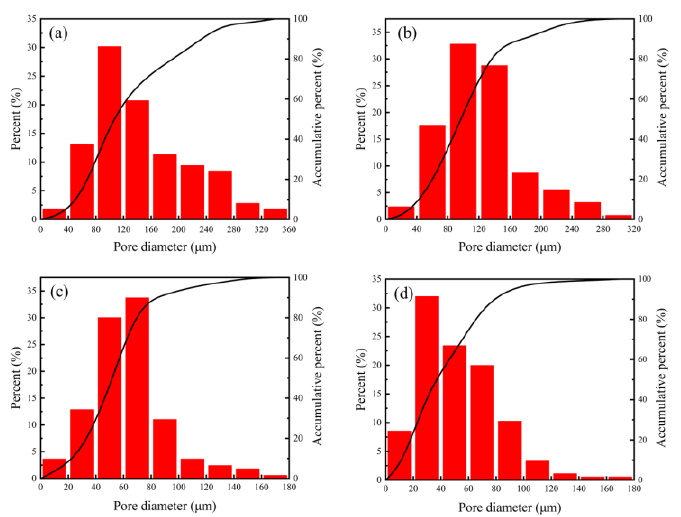
Figure 8. The pore diameter distribution of sintered porous NiTi alloys with different solid loading rates: ( a ) 42 vol.%; ( b ) 45 vol.%; ( c ) 48 vol.%; ( d ) 51 vol.%. rates: ( a ) 42 vol.%; ( b ) 45 vol.%; ( c ) 48 vol.%; ( d ) 51